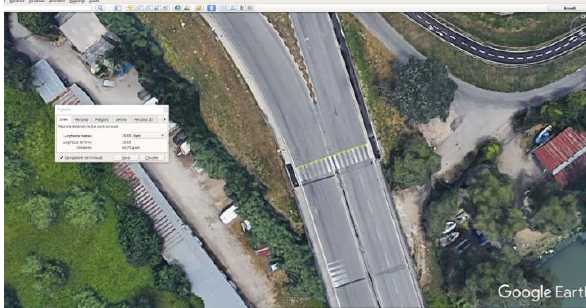
Figure 6: the measurement acquired by Google Earth is 15.6